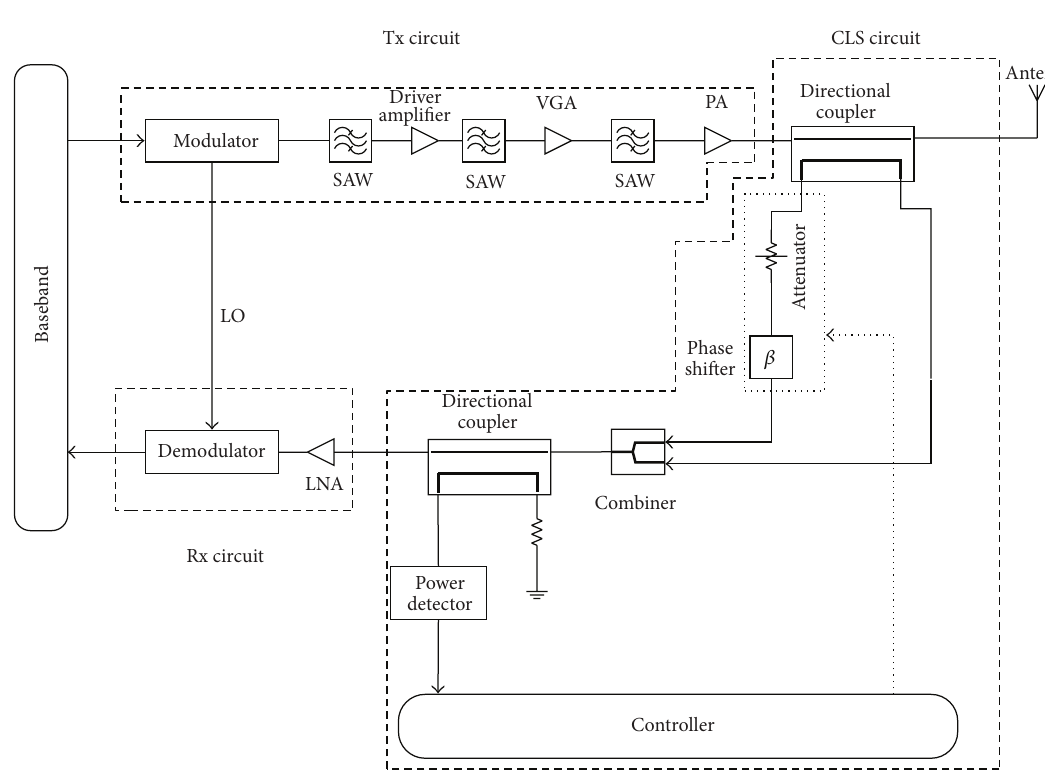
Figure 2: Block diagram of the proposed RF